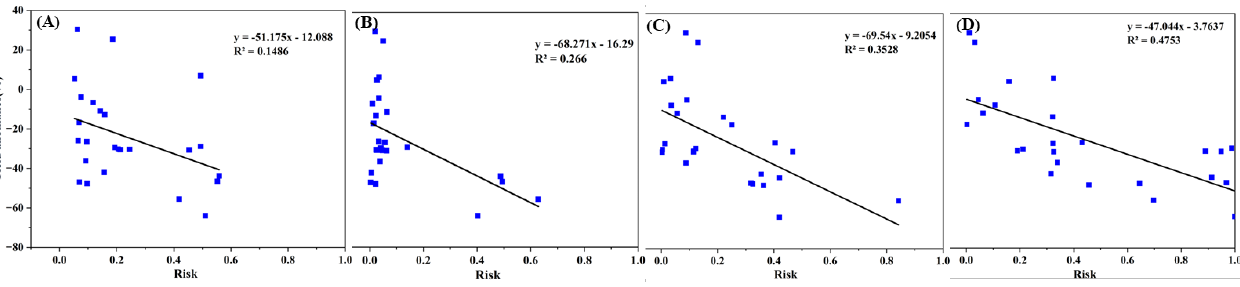
Figure 13. Linear relationship between yield anomalies in the growing season of sugarcane and drought disaster risk in Guangxi. ( A – D ) represent the stages of seedling, tillering, stem elongation, and maturity, respectively.